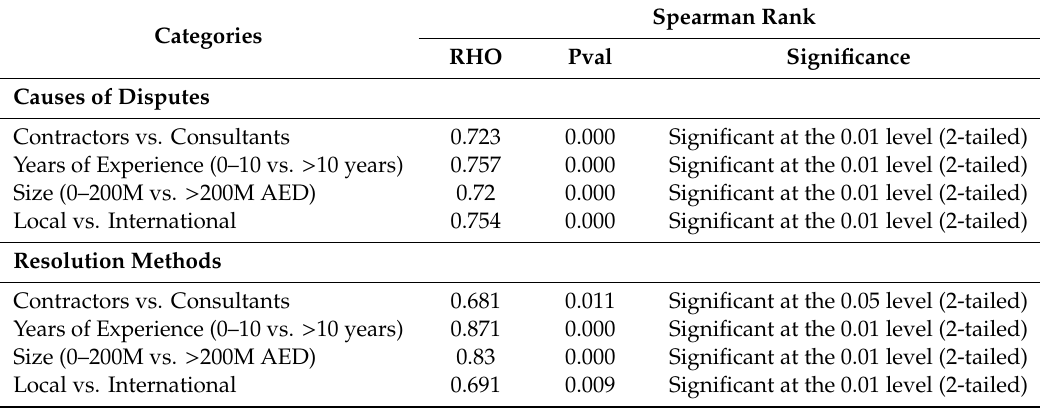
Table 6. Comparative analysis.